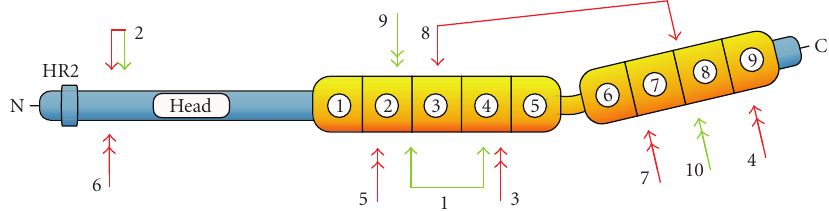
Figure 2: Position of mutations in human PKP 1 gene. Schematic representation of the protein structure of PKP 1 with head domain “Head” in blue color containing the homologous region 2 “HR2” near the amino-terminus which is followed by nine armadillo repeats (yellow boxes; numbered in circles from 1 to 9). Finally, a short domain (blue) at the carboxyl-terminus is shown. Positions of homozygous mutations are marked by double arrows, positions of compound heterozygous mutations by connected arrows. Green arrows designate mutations a ff ecting the coding region, red arrows denote splice-site mutations. For numbering and references of the mutations see Table